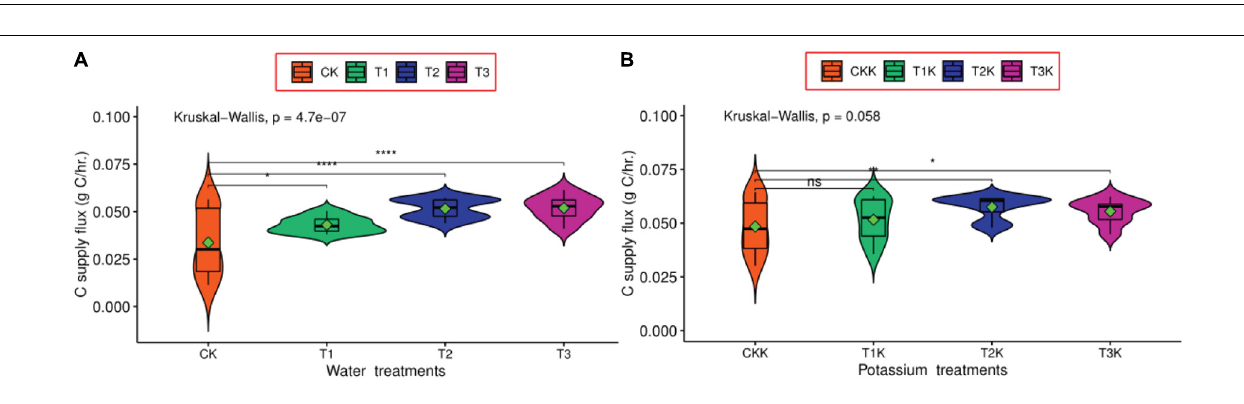
FIGURE 3 | Diurnal variation of carbon supply flux between K 0 and K 1 treatments during the all growth stages. K 0 indicates no potassium and K 1 indicates potassium addition. The Wilcoxon signed rank test was used, ns denotes no significant difference, * denotes significant difference at the confidence level P < 0.05, *** denotes significant difference at the confidence level P < 0.001, **** denotes significant difference at P < 0.0001. (A) Carbon supply for different water treatments. (B) Carbon supply for different water and potassium